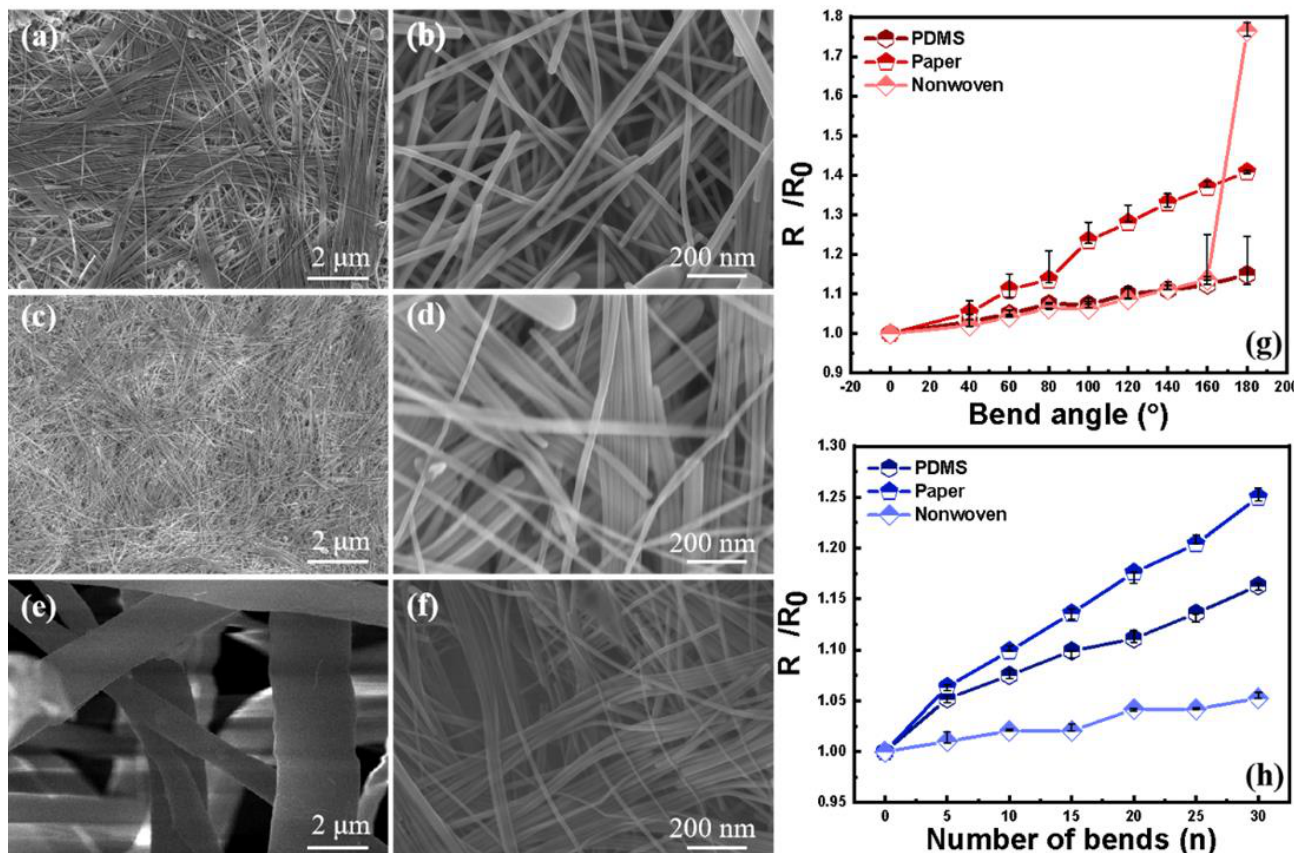
Figure 9. ( a , b ) SEM images of PDMS − based flexible stretchable electrode; ( c , d ) SEM images of the paper − based flexible stretchable electrode; ( e ) SEM images of the nonwoven; ( f ) SEM images of the nonwoven − based flexible stretchable electrode; ( g ) The change of square resistance of PDMS/paper/nonwoven − based flexible stretchable electrode in the bending range of 0~180 °; ( h ) The change of square resistance of PDMS/paper/nonwoven − based flexible stretchable electrode after bending 1~30 times.